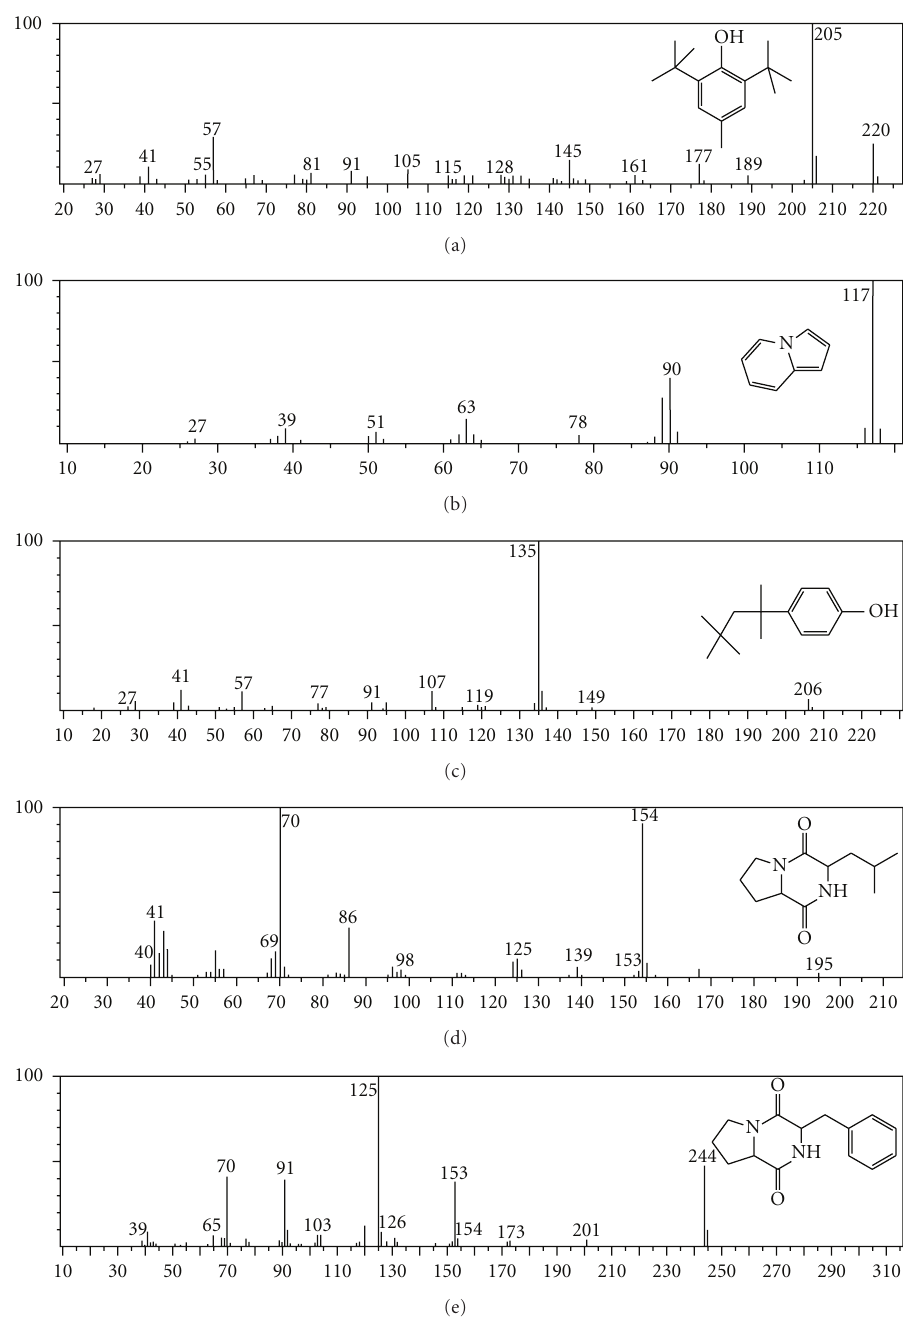
Figure 7: Molecular structure and corresponding GC-MS peaks of major antibacterial metabolites from crude cell extract of Aeromonas hydrophila strain An4. (a) Butylated Hydroxytoluene(BHT)—[Peak 205], (b) Pyrrolo[1,2-a] pyridine [peak 117.15], (c) (1,1,3,3-tetramehyl butyl)-Phenol [Peak 135], (d) Pyrrolo(1,2-a) pyrazine-1,4-dione, hexahydro-3 (-2-methyl propyl)—[Peak 70.1], and (e) Pyrrolo(1,2-a) pyrazine-1,4-dione, hexahydro-3 (-2-phenyl methyl)—[Peak